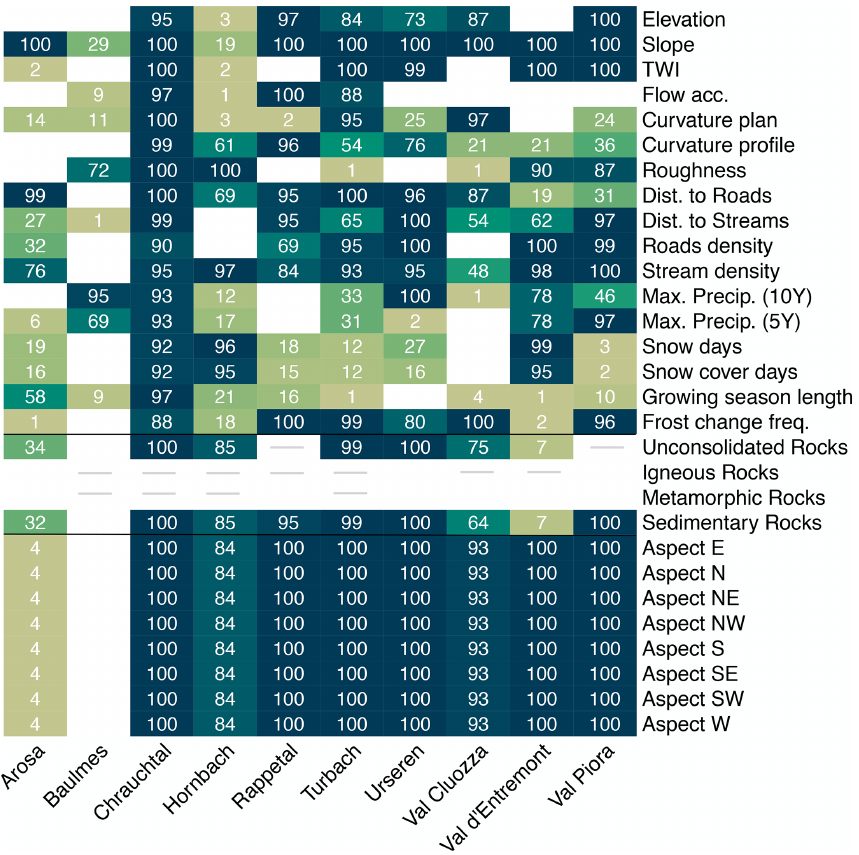
Figure 6. Heat map displaying the inclusion rate of variables for all 10 sites. The numbers indicate how often variables were selected for the models out of 100 estimates. Note that not all geological rock classes are present at all sites (grey line). Darker colours show variables selected more often. White boxes indicate which variables were never selected for the